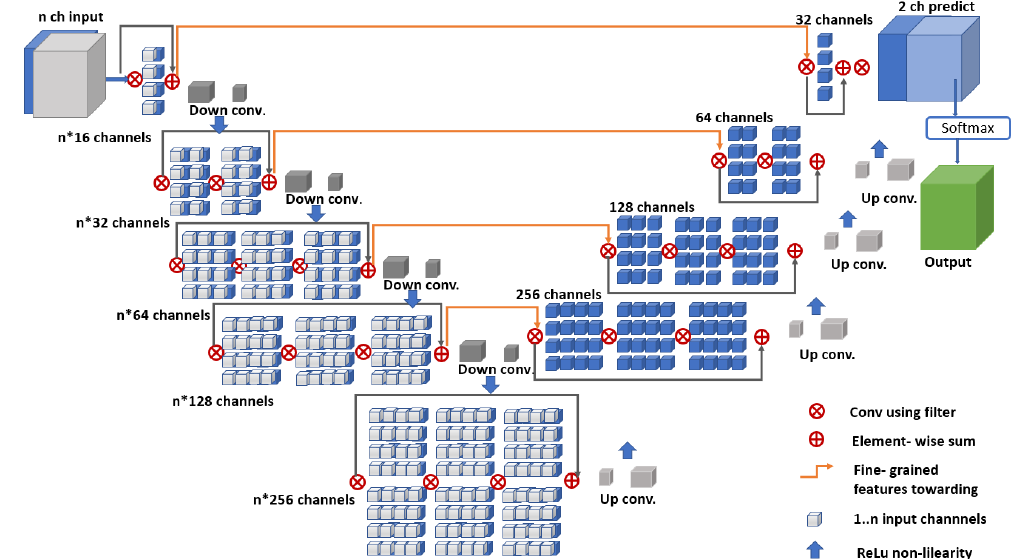
Figure 4. Schematic representation of the fusion V-Net architecture. The encoder phase consists of two fusion blocks, while the decoder phase consists of the classical V-Net block.